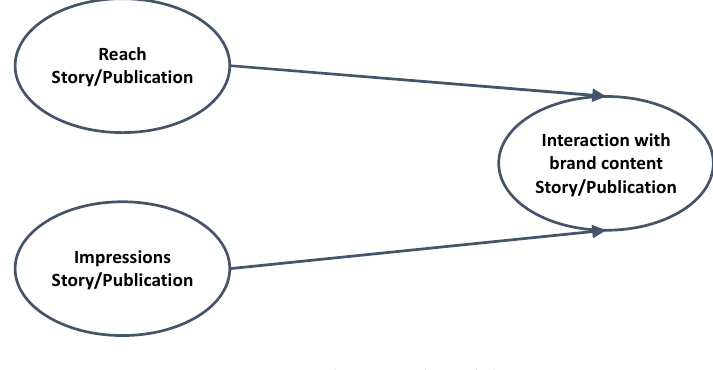
Figure 2. Theoretical model.